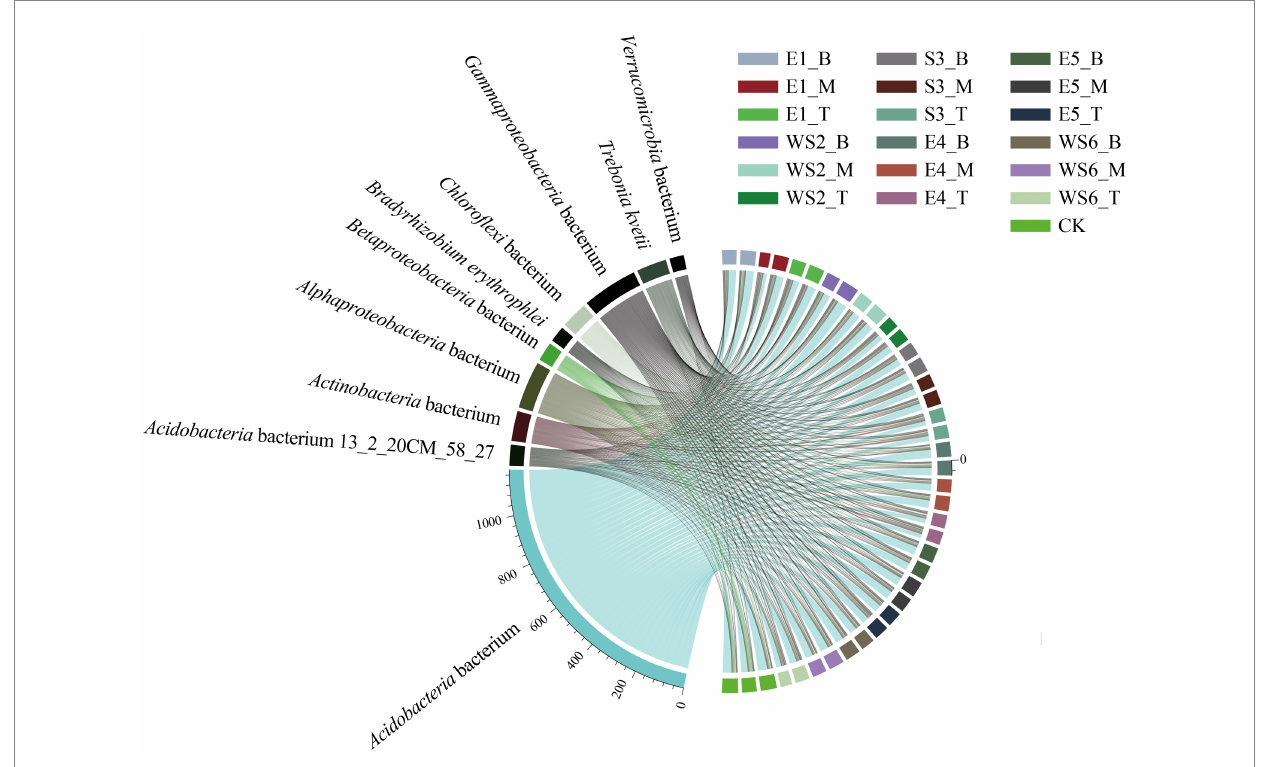
FIGURE 2 Collinear diagram of the top ten dominant microbial species from all samples.